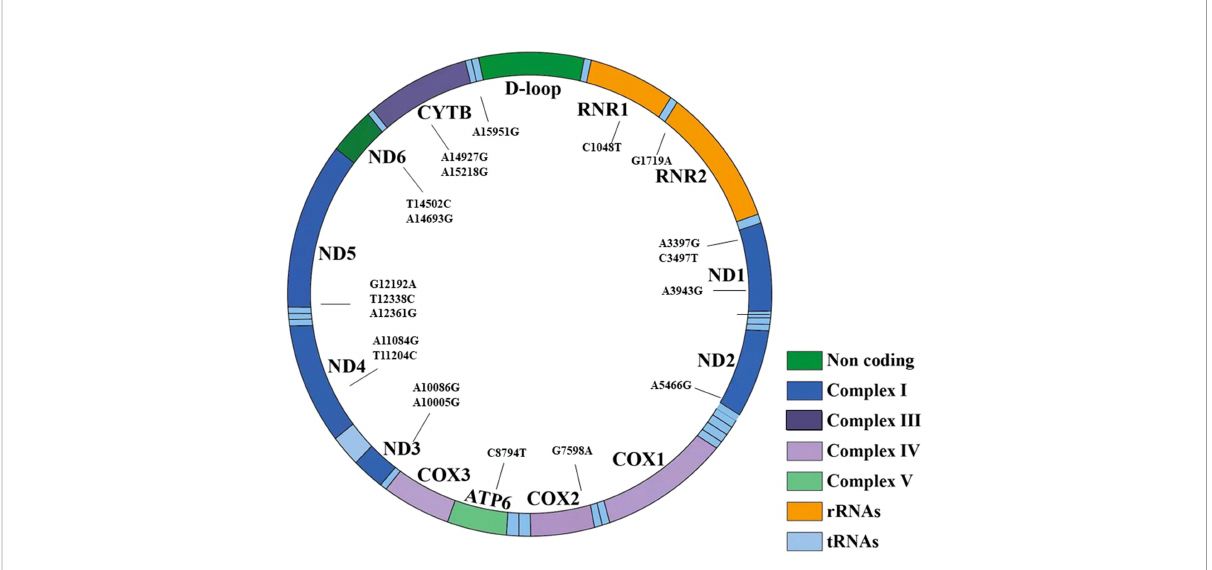
FIGURE 3 The 20 variants have been shown in the structure of the mitochondrial genes and different domains. It included seven regions: non-coding region, complex I, complex III, complex IV, complex V, transfer RNA, and